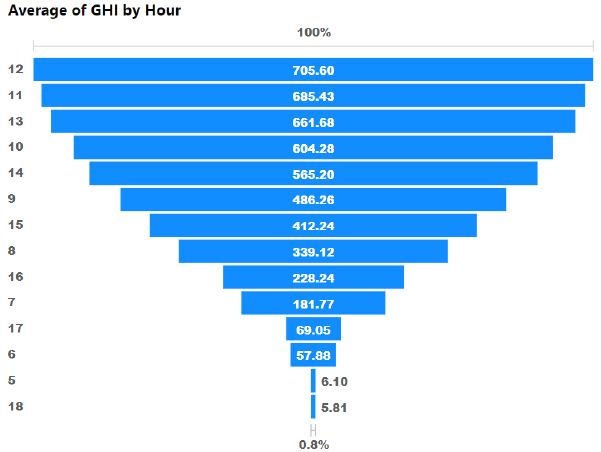
Figure 9. GHI recorded in W/s 2 for three years and hourly